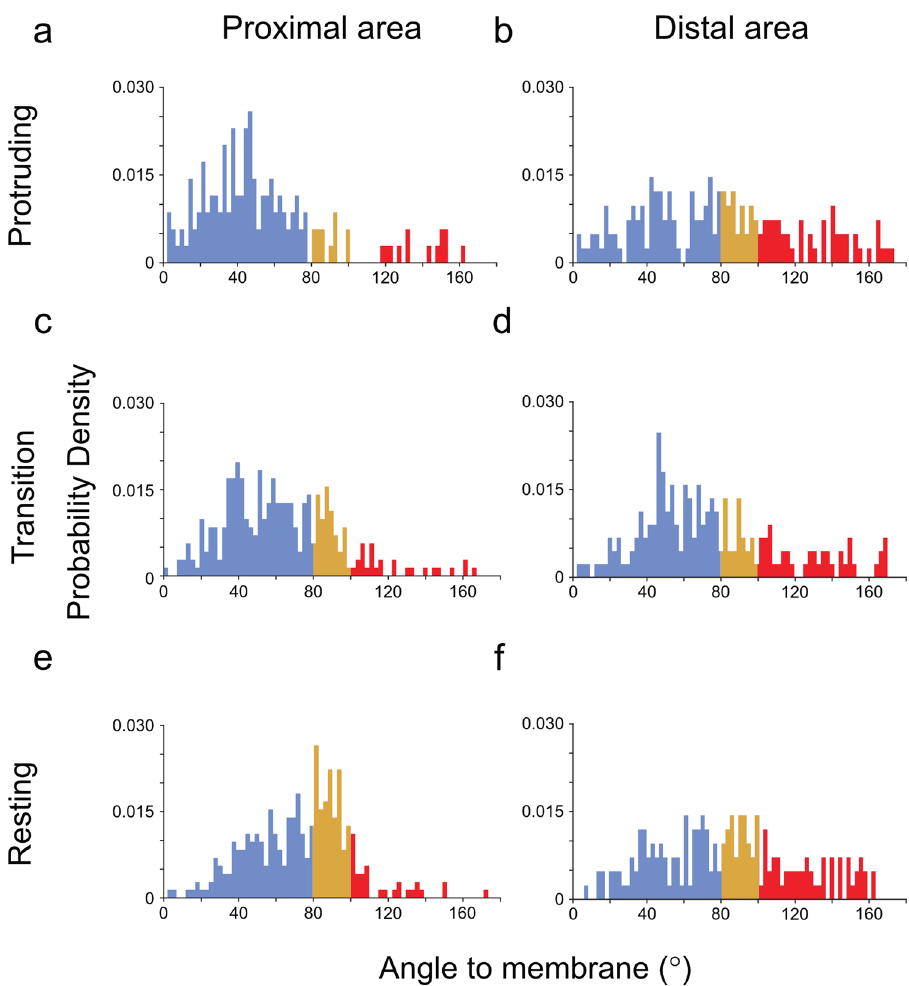
Fig. 5 The distribution of fi lament orientations in the three different lamellipodia sub-domains. The orientation of actin fi laments in respect to the plasma membrane is shown. The histograms show actin fi lament orientation at the membrane proximal regions and distal regions within the lamellipodia. Protruding ( a , b ), transition ( c , d ), and resting sub-domains ( e , f ). The fi lament-membrane orientation distribution at the membrane proximal (left) and distal areas (right). The colors indicate the angular orientation as shown in Fig.